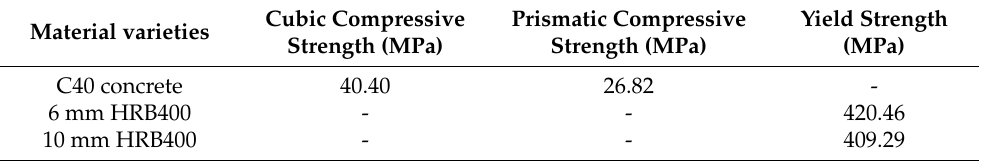
Table 1. The main mechanical properties of the concrete and steel bars on the test bridge slabs. Cubic Compressive Prismatic Compressive Yield Strength Material varieties Strength (MPa) Strength (MPa) (MPa) C40 concrete 40.40 26.82 - 6 mm HRB400 - - 420.46 10 mm HRB400 - - 409.29